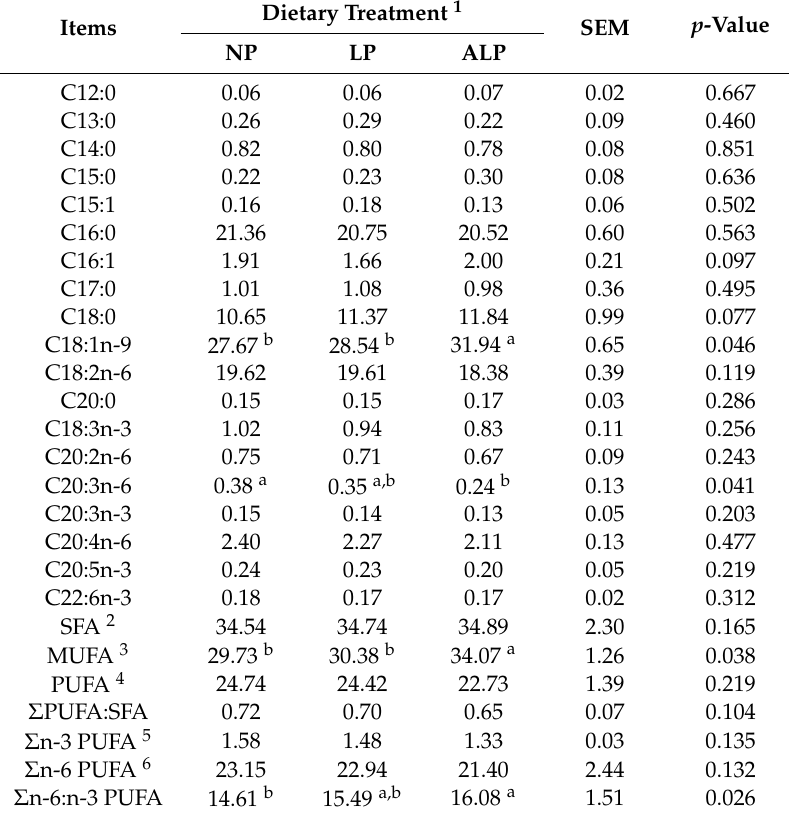
Table 5. Fatty acid composition (% of total fatty acids) of biceps femoris muscle of growing pigs fed normal protein or low-protein diets without or supplemented with AKG. Dietary Treatment 1 Items SEM p -Value